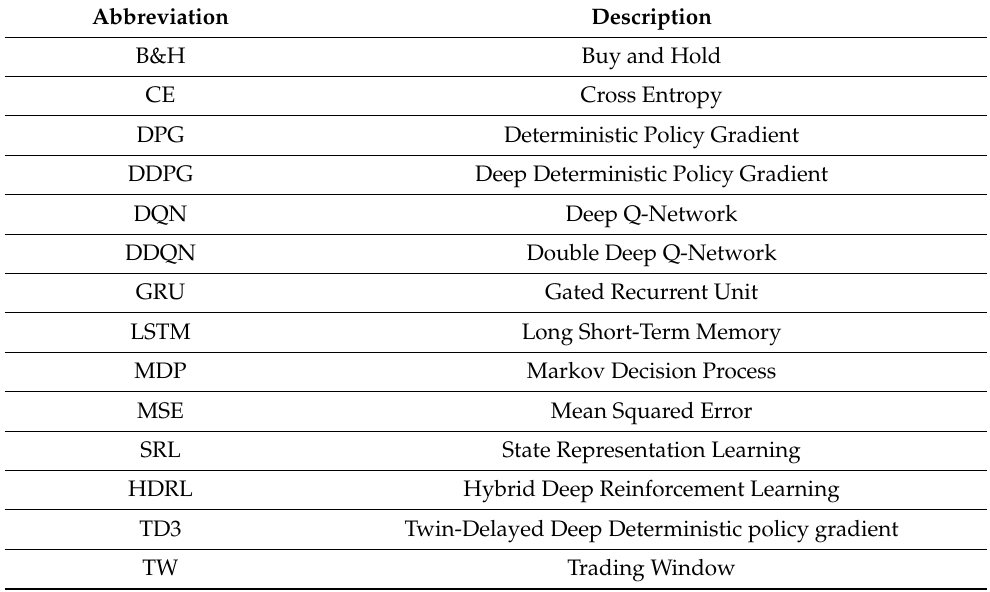
Table A2. List of